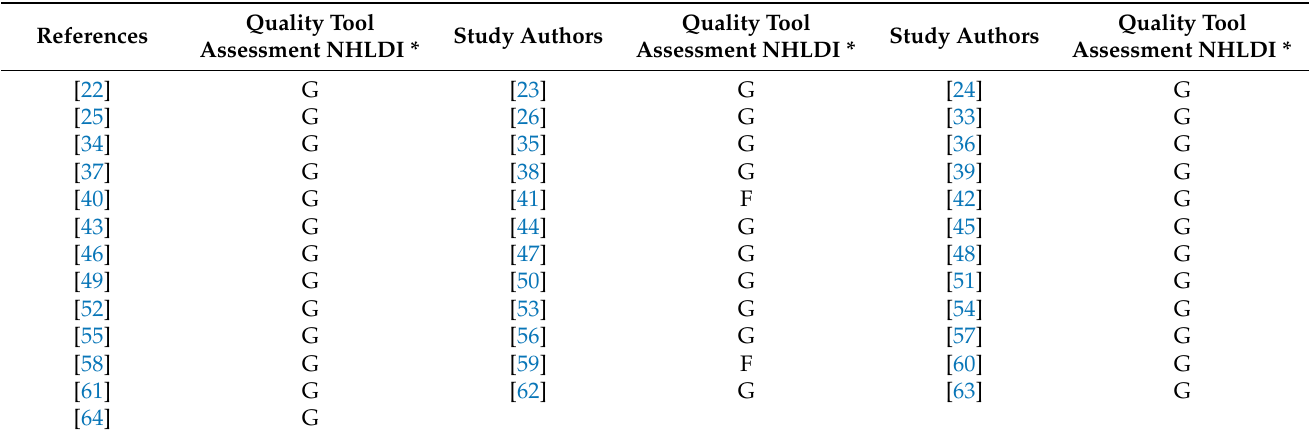
Table 1. Summary of Overall Risk of bias within studies and quality